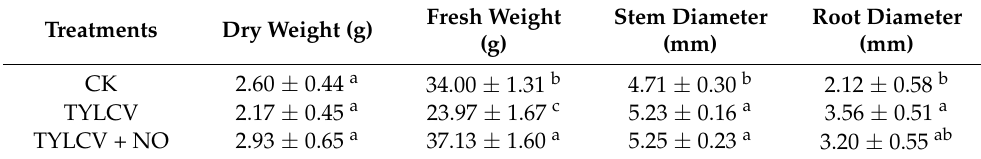
Table 1. Effects of exogenous NO on biomass and stem/root diameter of susceptible tomato.